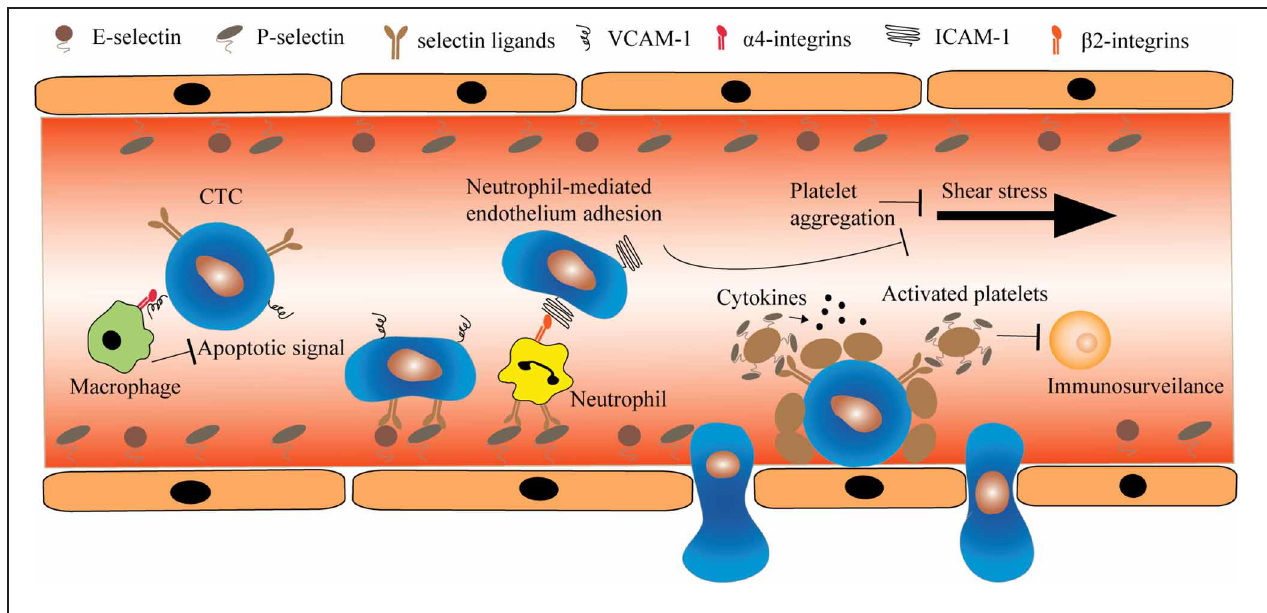
FIGURE 1 | The heterotypic cell interactions between CTCs and haemopotoeic cells in the circulation. Macrophages interact with CTCs via α 4-integrin-VCAM-1 ligation and transmit anti-apoptotic signal such as TRAIL to CTCs. In contrast, certain CTCs deficient for selectin ligands can roll and adhere to endothelial cells through heterotypic interaction